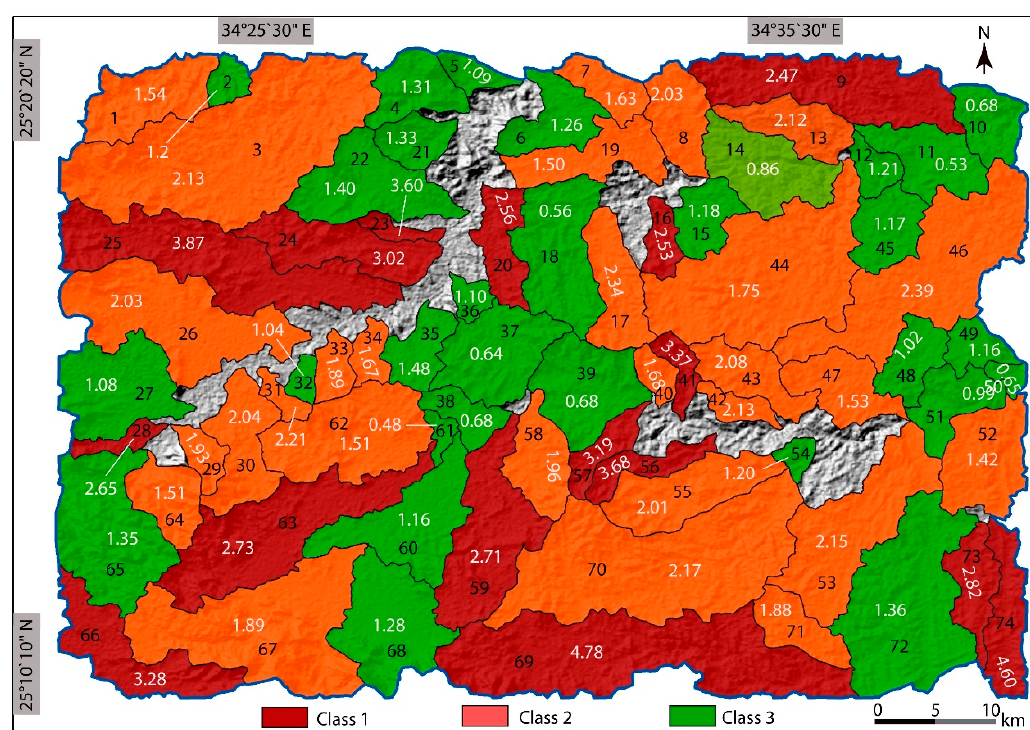
Figure 8. Map showing basin shape index (B S ) values in white numbers and tectonic classes. Black numbers refer to the sub-catchment reference numbers.